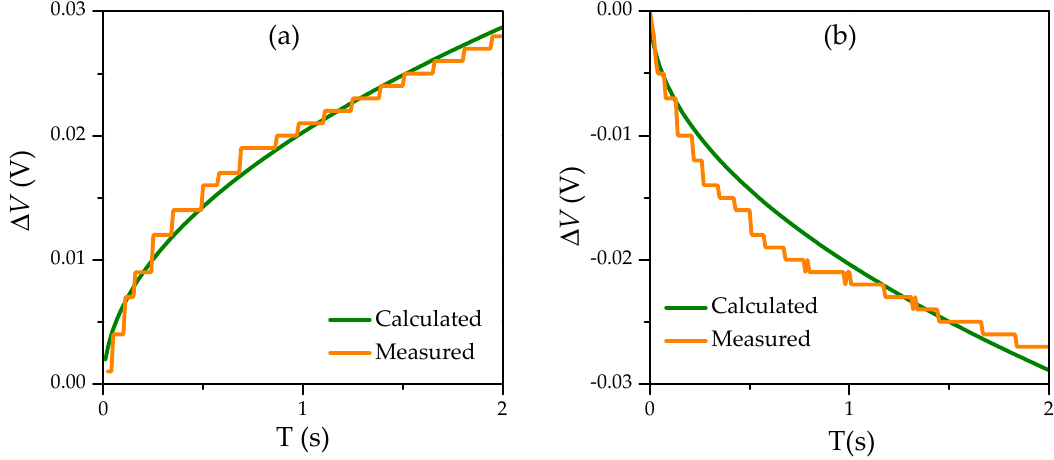
Figure 8. Representation of dynamic behavior of UC voltage using reverse Fourier transform ( a ) charging process, ( b ) discharging process. The UC characteristics are measured at constant input current of 20 A and temperature of 30 °C.